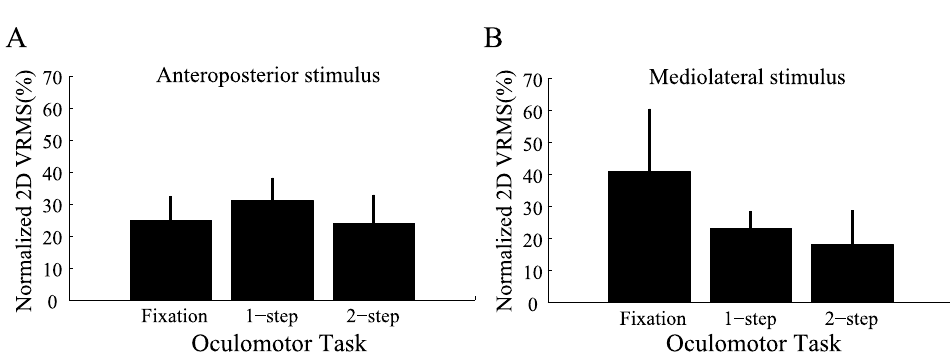
Fig 5. Mean normalized 2-D vRMS as a function of oculomotor task. Checkerboard stimulus moving in the (A) anteroposterior and (B) mediolateral directions. Data from all subjects and trials was pooled.Error bars = standarderror of the